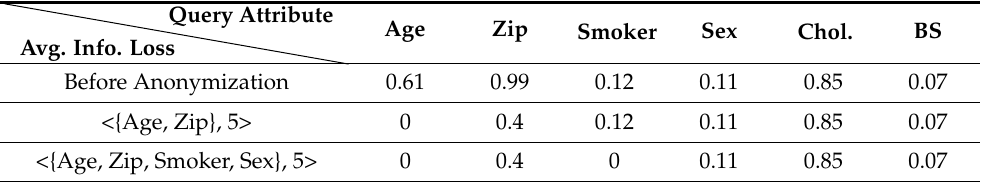
Table 8. Post anonymization analytics of Cleveland Dataset